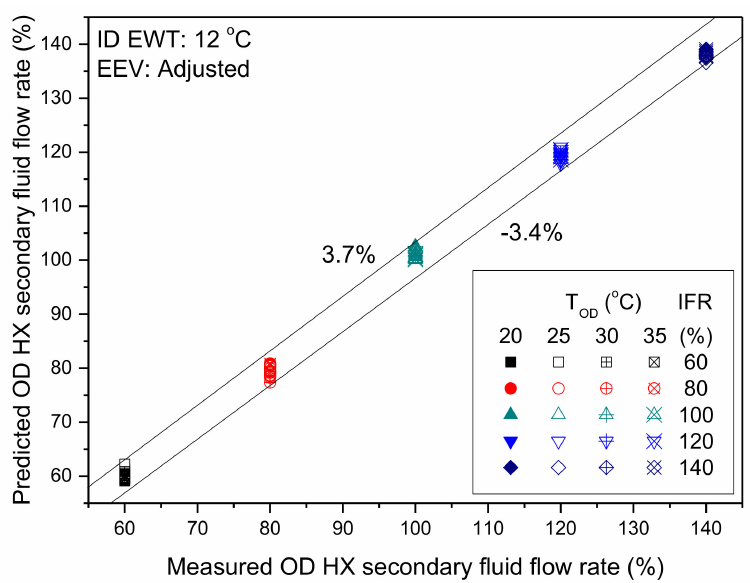
Figure 15. Comparison between predicted and measured condenser SFFR using MSSFF correlation.